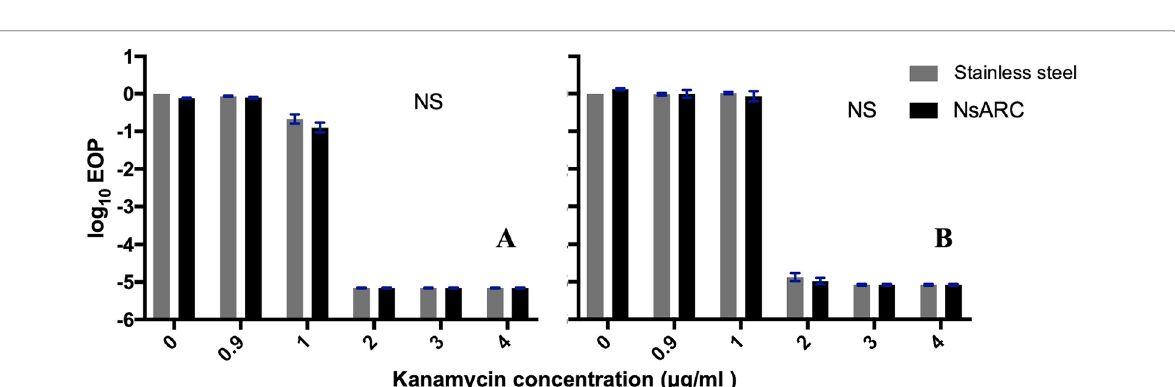
Fig. 2 Response of S. aureus to various concentrations (µg/ml) of kanamycin after exposure to stainless steel and NsARC ( A ) under visible light ( B ) in the dark. Error bars are standard error of means (SEM). Asterisks indicate P values. *P < 0.05; **P < 0.01; ***P < 0.001; NS not significant